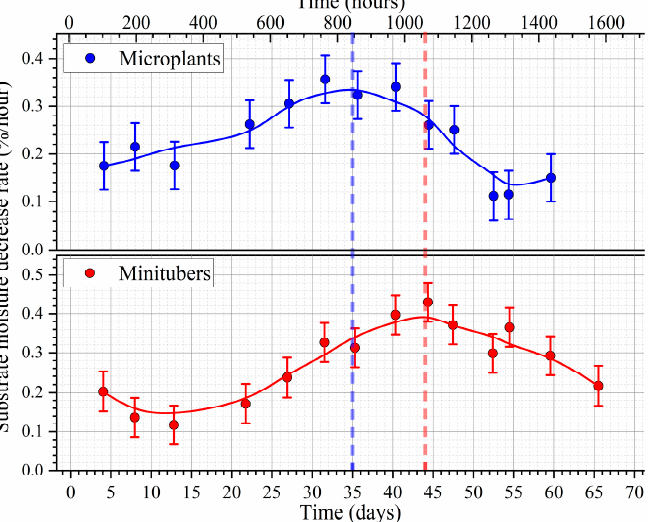
Figure 4. Dynamics of substrate moisture decrease rate for microplants and minitubers. Vertical dotted lines indicate the location of the extrema of the dependencies under